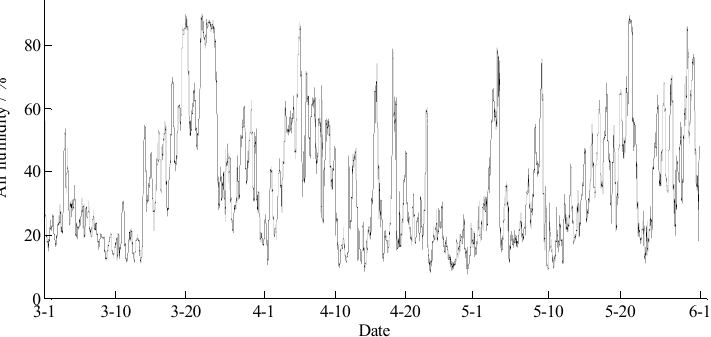
Figure 10. The curve of air humidity in Yan’er Ridge.